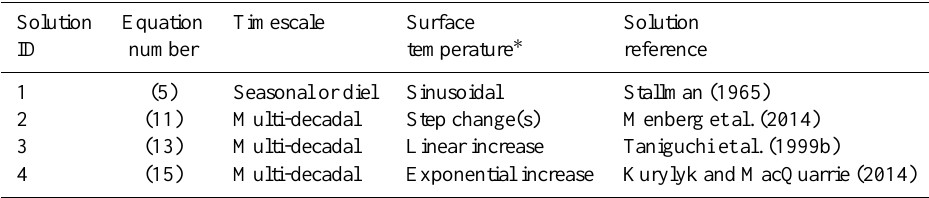
Table 1. Details regarding the four analytical solutions employed in this study. Solution Equation